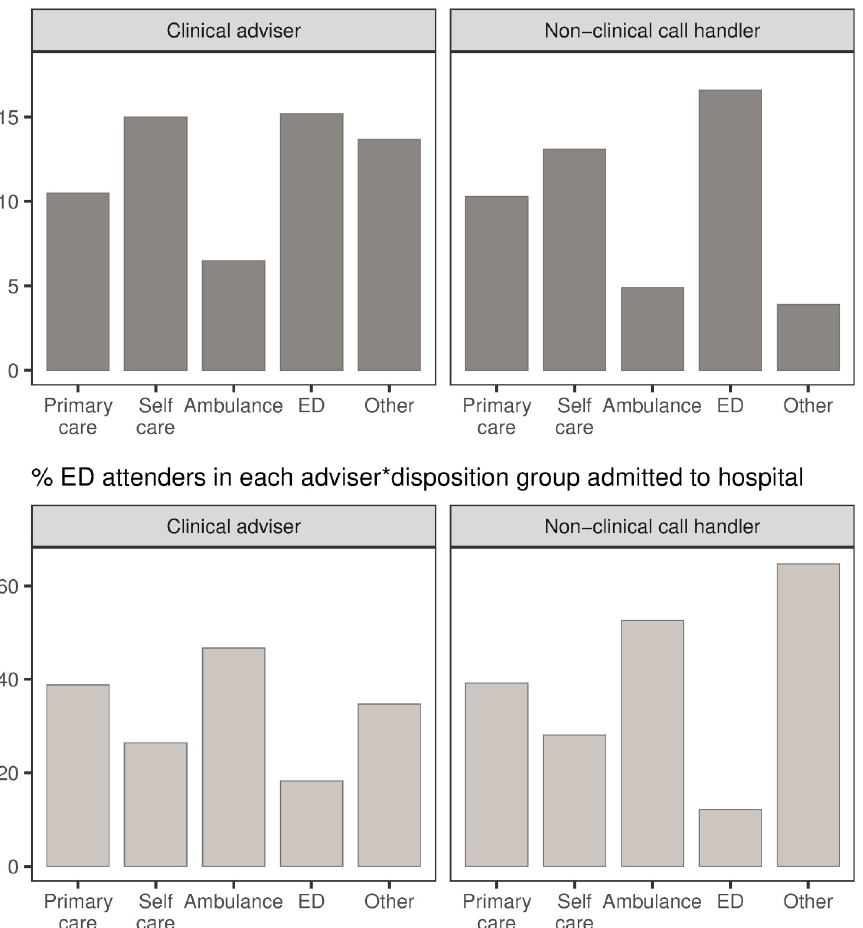
Fig 6. Proportion of ED attendees from each disposition considered non-urgent, and those admitted, by call handler. Top: percent of NHS 111 callers in each adviser-disposition group who attended ED, who were classed as non-urgent; e.g., 10.5% of callers who were advised by a clinical adviser and received a primary care disposition but attended ED, were classed as non-urgent. Bottom: percent of NHS 111 callers in each adviser-disposition group who attended ED, who were subsequently admitted; e.g., 38.8% of callers who were advised by a clinical adviser and received a primary care disposition but attended ED, were admitted. Note that absolute numbers of patients in these disposition groups are markedly different (see Fig